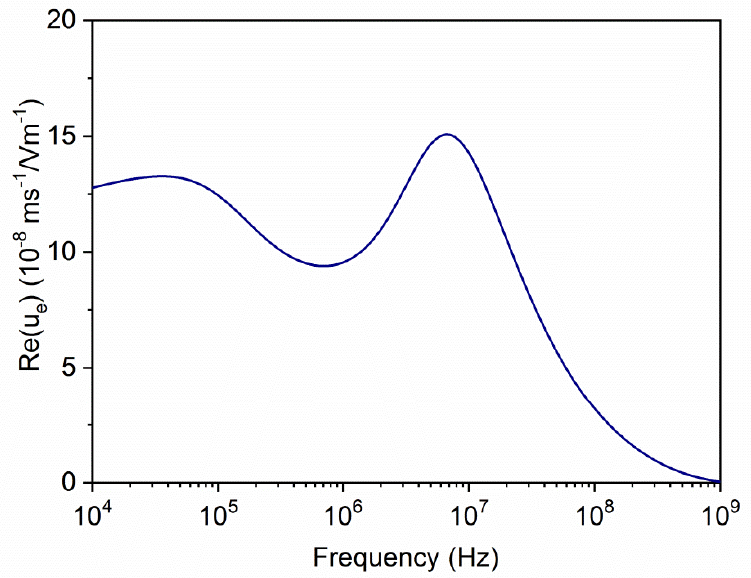
Figure 4. Real part of the dynamic mobility as a function of the field frequency for the same particle considered in Figure 3.